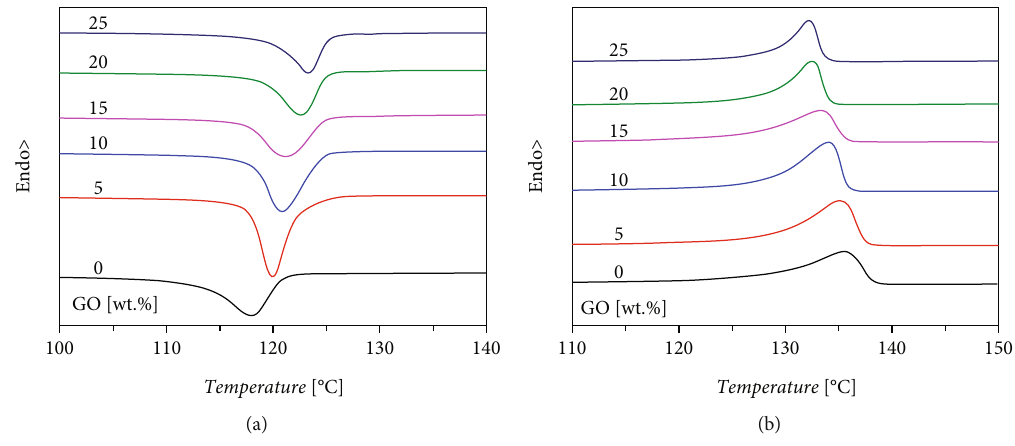
Figure 9: The DSC curves of GO/oxidized UHMWPE composites. Table 4: The DSC data of oxidized UHMWPE